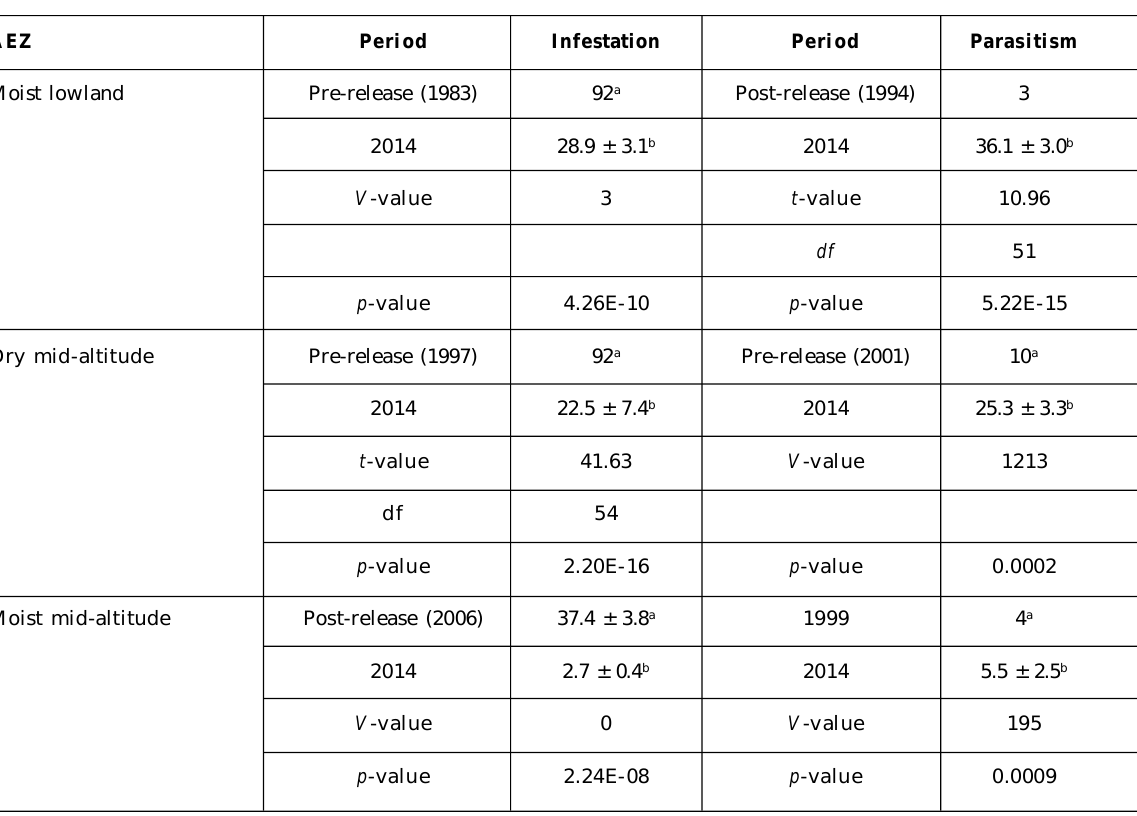
Table 4: Plant infestation by stem borers and parasitism levels before and after C. flavipes release in moist lowland, dry mid-altitude and moist mid-altitude AEZs in Kenya AEZ Period Infestation Period Parasitism Moist lowland